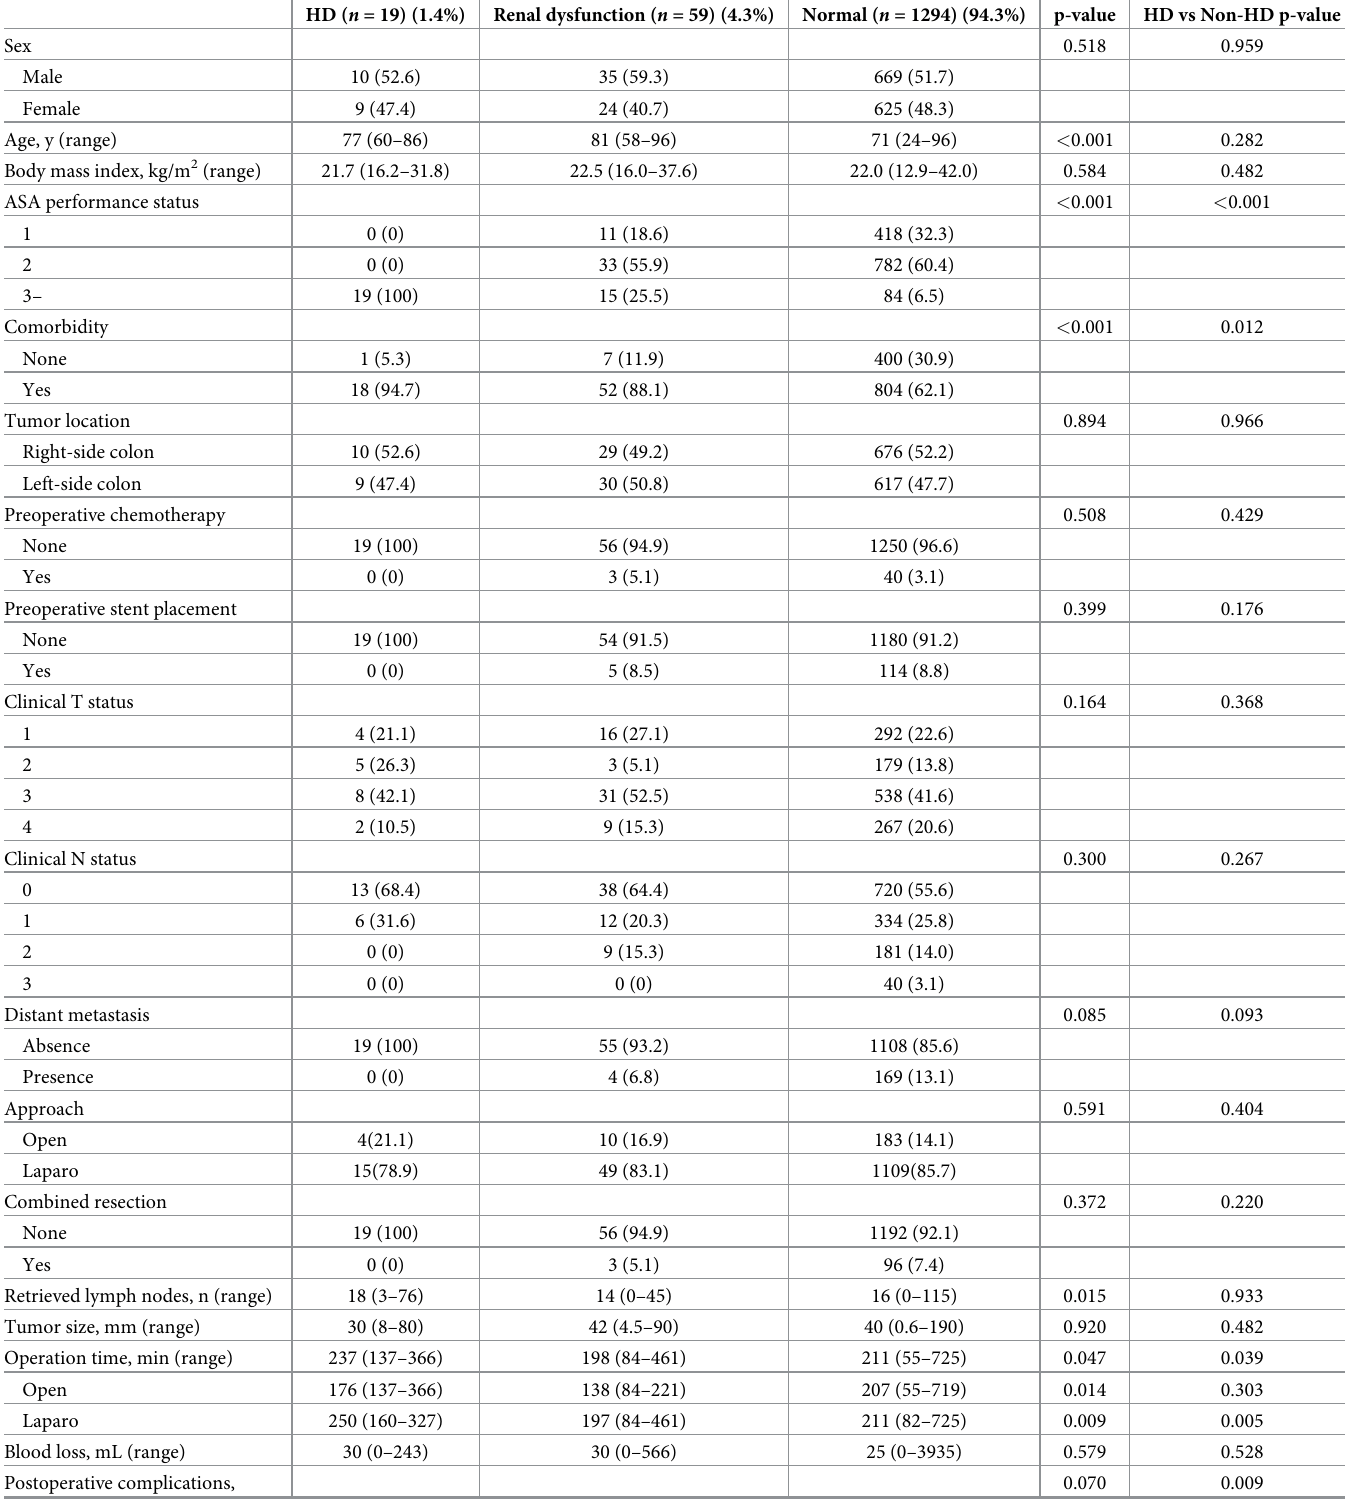
Table 2. Comparison of clinicopathological characteristics by renal function